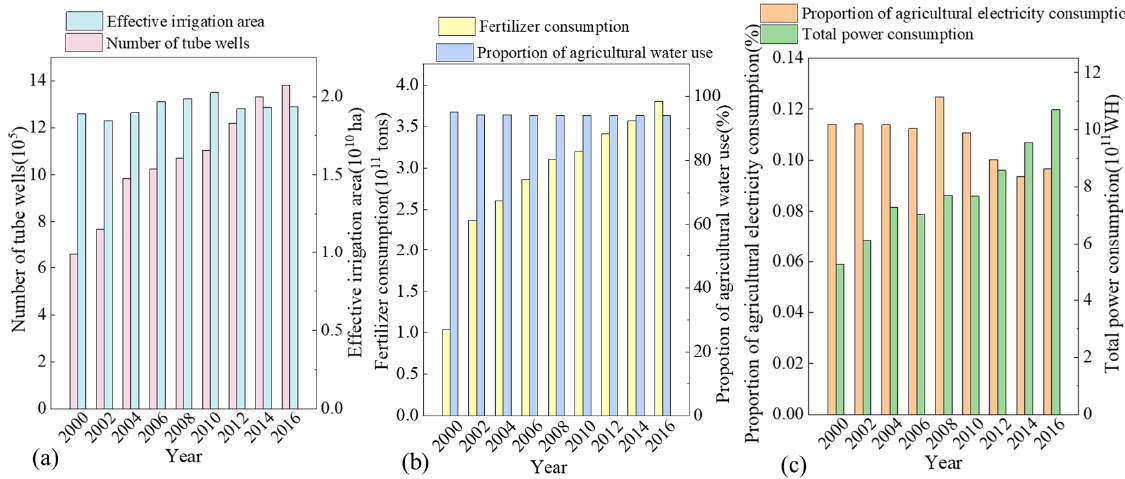
Figure 6. ( a ) The proportion of agricultural electricity consumption and total electricity consumption in the period 2000–2016. ( b ) Fertilizer consumption and agricultural water-use ratios in the period 2000–2016. ( c ) Distribution of tube wells and irrigation areas in the period 2000–2016.